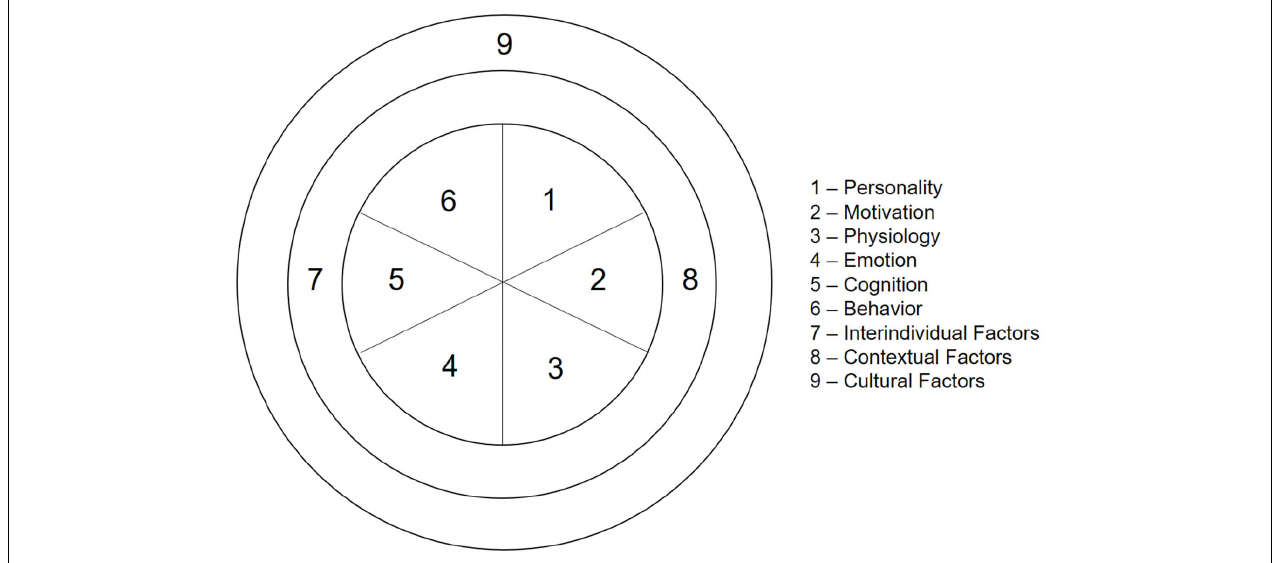
FIGURE 1 | Categorization of flow research